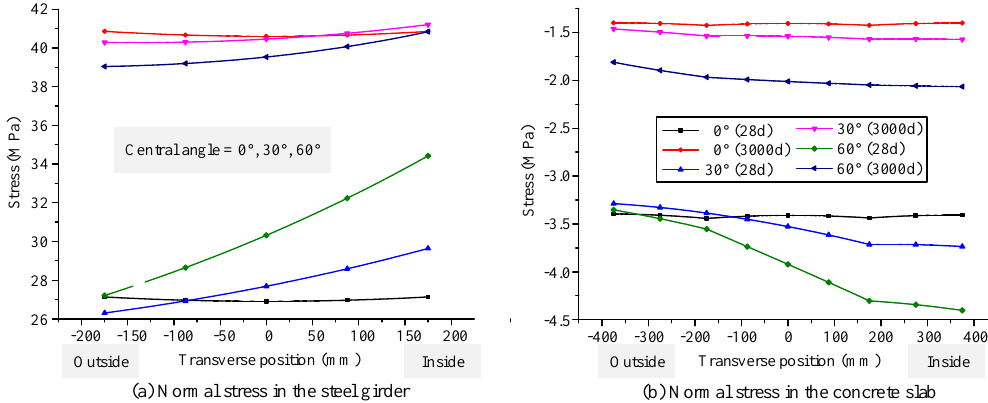
(c) Longitudinal displacement (a) Deflection along the span (b) Transverse displacement along the span along the span Figure 9. Displacement distribution along the span of the curved composite box girder, with different central angles at the initial loading age and ultimate loading age: ( a ) deflection along the span, ( b )transverse displacement along the span, ( c ) longitudinal displacement along the span.